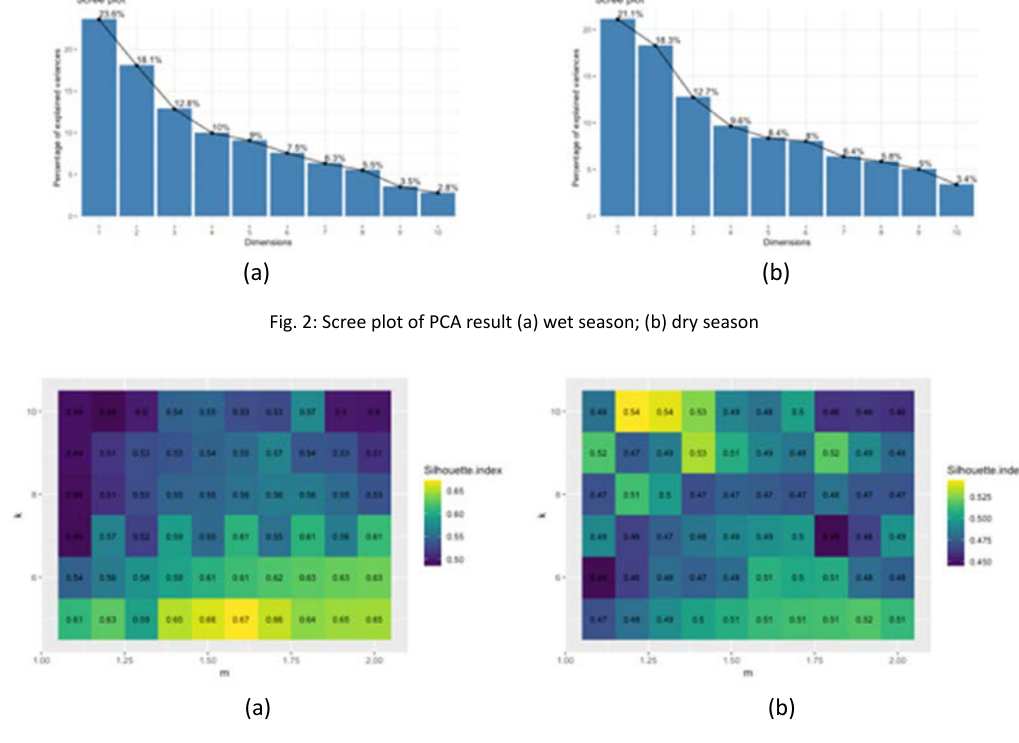
Fig. 3: Silhouette index plot of FCM (a) wet season; (b) dry season